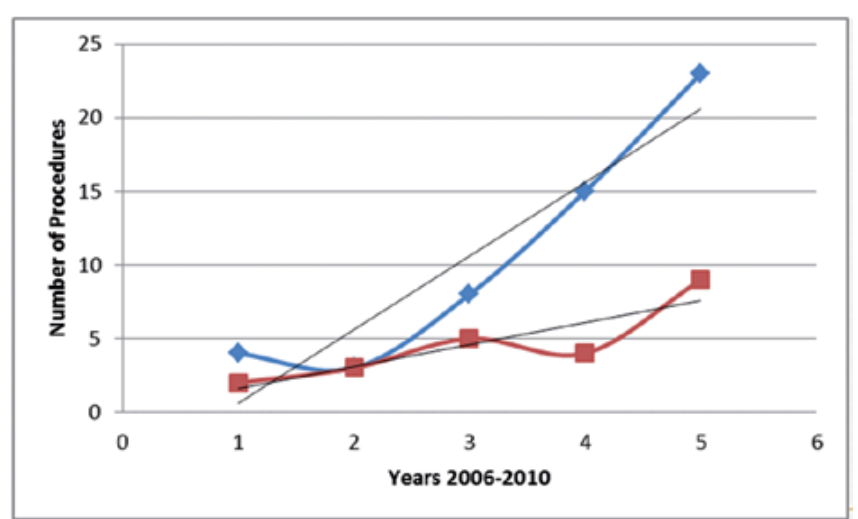
figure 2 - Yearly depiction of number of